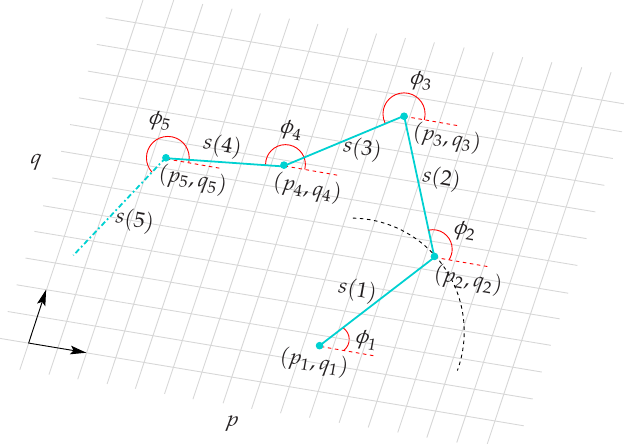
Figure 1. Descriptive construction of the auxiliary trajectory in the ( p , q )